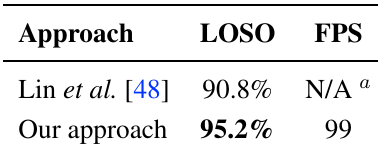
Table 9. LOSO cross-validation results obtained on the depth-included human action (DHA) dataset (10 Weizmann